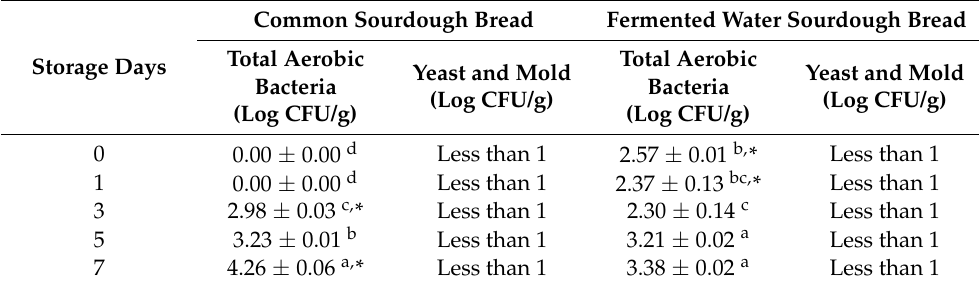
Table 4. Total aerobic bacteria and yeast and mold of common sourdough bread and fermented water sourdough bread over storage duration.